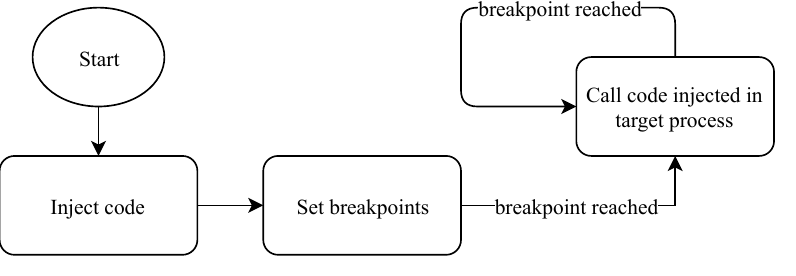
Figure 4. Manager operation